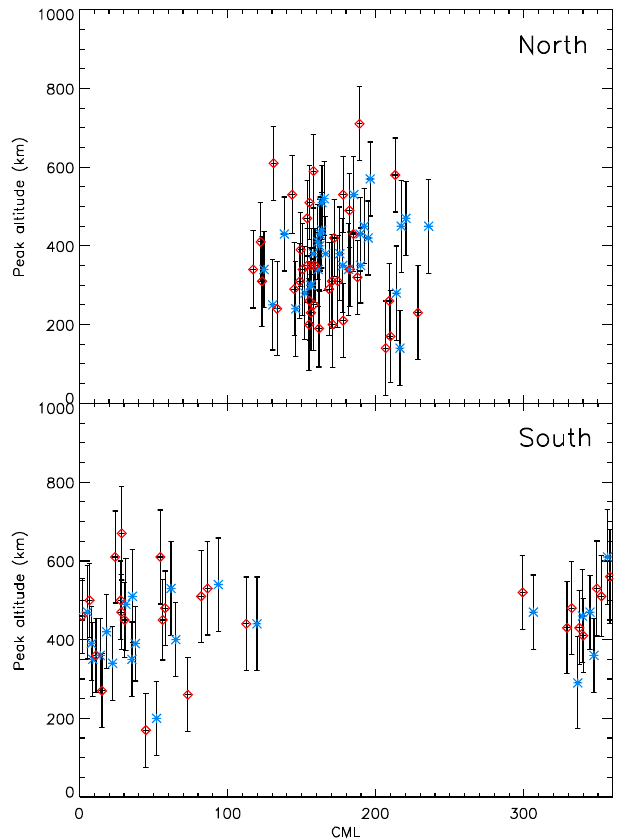
Figure 2. Plots of the altitude of the brightness peak of the main emission above the limb for the northern (top) and southern (bot- tom) hemispheres. Observations acquired with the F125LP filter are noted with blue stars and observations acquired with the F115LP filter are noted with red diamonds. The error bars represent the un- certainty regarding the altitude due to the uncertainty regarding the planetary center location. Table 1. This table lists the mean and standard deviation of the mea- sured altitude of the brightness peak in the main auroral emissions as observed above the limb for both hemispheres and filters. The uncertainty regarding the mean altitude represents the 95% confi- dence interval and is computed as twice the standard error of the , with N being the number of observations. mean σ m = σ √ N